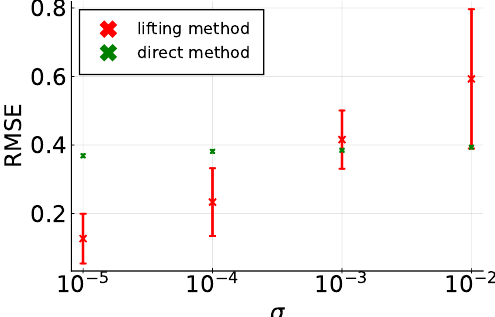
Figure 5. The lifting method is characterized by a smaller RMSE for low noise levels. However, the direct method is more robust to noise and outperforms the lifting method for larger noise levels. The dataset is generated with the dynamics (18). Crosses and error bars show the mean and standard deviation, respectively, of the RMSE (over 20 experiments). Note that experiments characterized by | ˆ c ( 1 ) − ˆ c ( 2 ) | > 1 for some i are i i